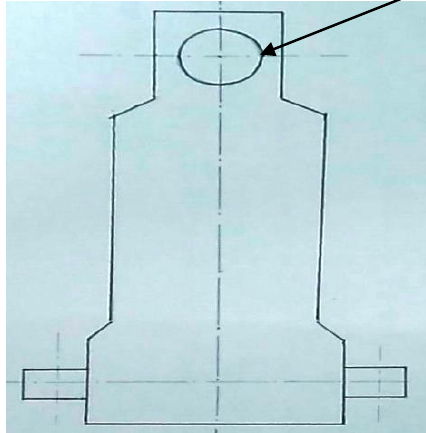
Figure 9. Bottom case with axle hole in centre After